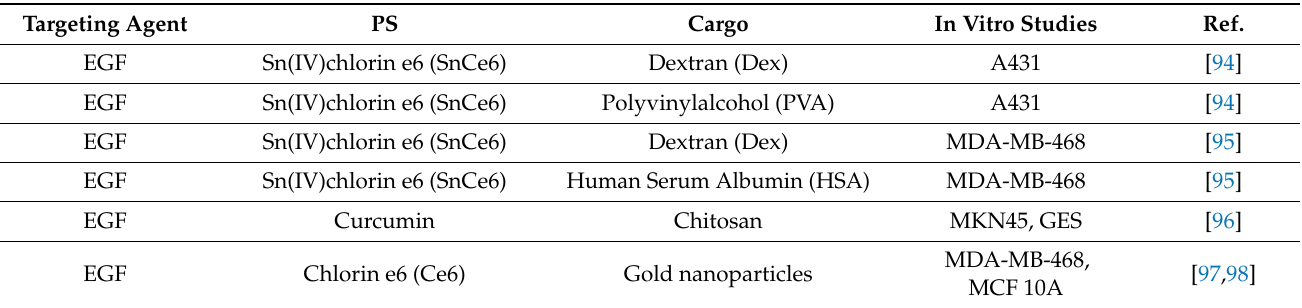
Table 2. EGFR-targeted PDT performed with EGF as the targeting agent and conjugated with carrier